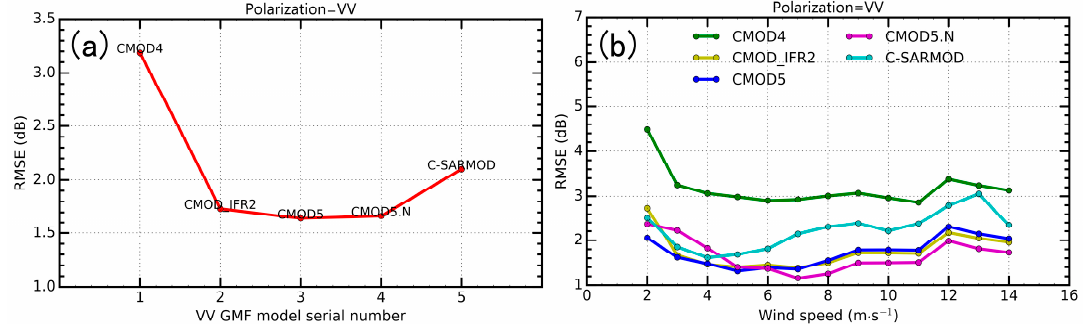
Figure 6. RMSE of GMFs compared to GF-3 NRCS of VV polarization. ( a ) Each RMSE is from the full data; and ( b ) each RMSE is from a wind speed bin of 1 m·s − 1 . GMFs used include CMOD4, CMOD_IFR2, CMOD5, CMOD5.N, and C-SARMOD. The winds used in the GMFs are from GFS.